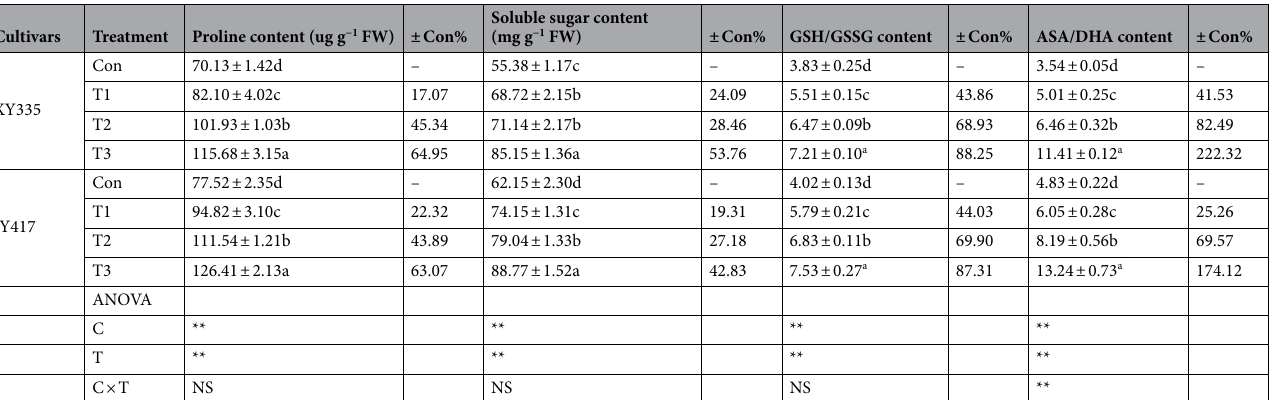
Table 5. Influence of T. asperellum on the content of non-enzymatic systems in the roots of maize seedlings in saline–alkaline soil (± SD). Con, T1, T2, and T3 indicate 0, 1 × 10 3 , 1 × 10 6 , 1 × 10 9 spores L −1 suspension, respectively. Non-enzymatic system contents were measured on the 27 th day after T. asperellum application. C and T indicated cultivars and treatments, respectively. Different letters within a column represented significantly different at 5% probability level, and the numerical value was the mean value of five repeats. Differences between treatments were calculated for each particular cultivar. NS, not significant. * and **, significant at the 0.05 and 0.01 probability level, respectively.